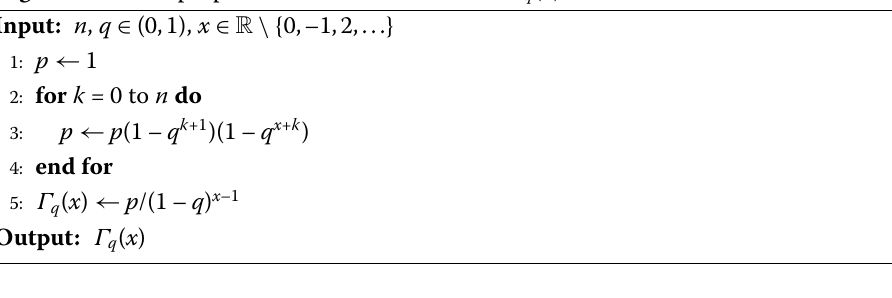
Algorithm 3 The proposed method for calculated ( D q f )( x